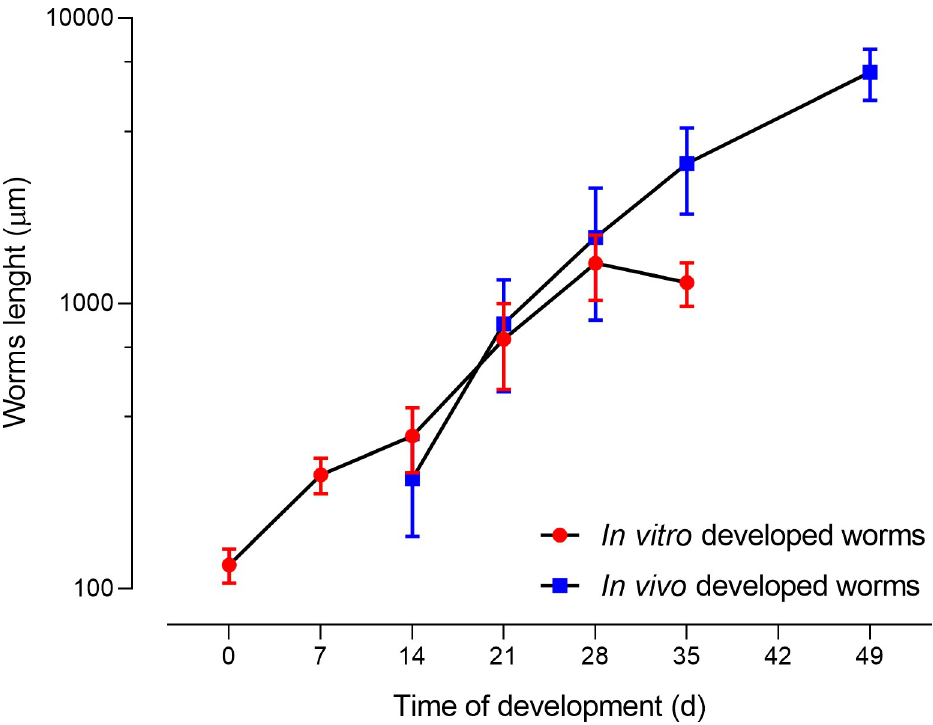
Fig 1. Comparison of the length of S . mansoni developed in vitro with those developed in vivo . Each point represents the average length of 22 worms including males and females.